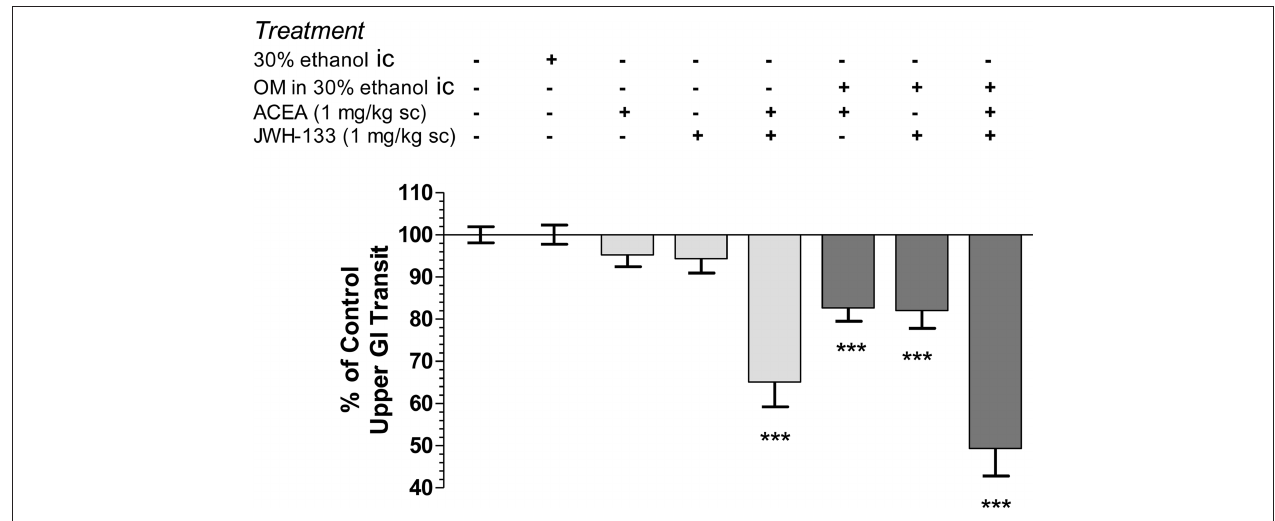
Figure 4 | intracolonic 30% ethanol had no impact on upper gi transit, measured 28 days later, compared to wild-type controls. CB1R (ACEA 1 mg/kg) and CB2R (JWH-133, 1 mg/kg) agonists alone inhibited small intestinal transit in mice 28 days post-OM administration, but not in control mice. A combination of both agonists inhibited transit in both groups. All